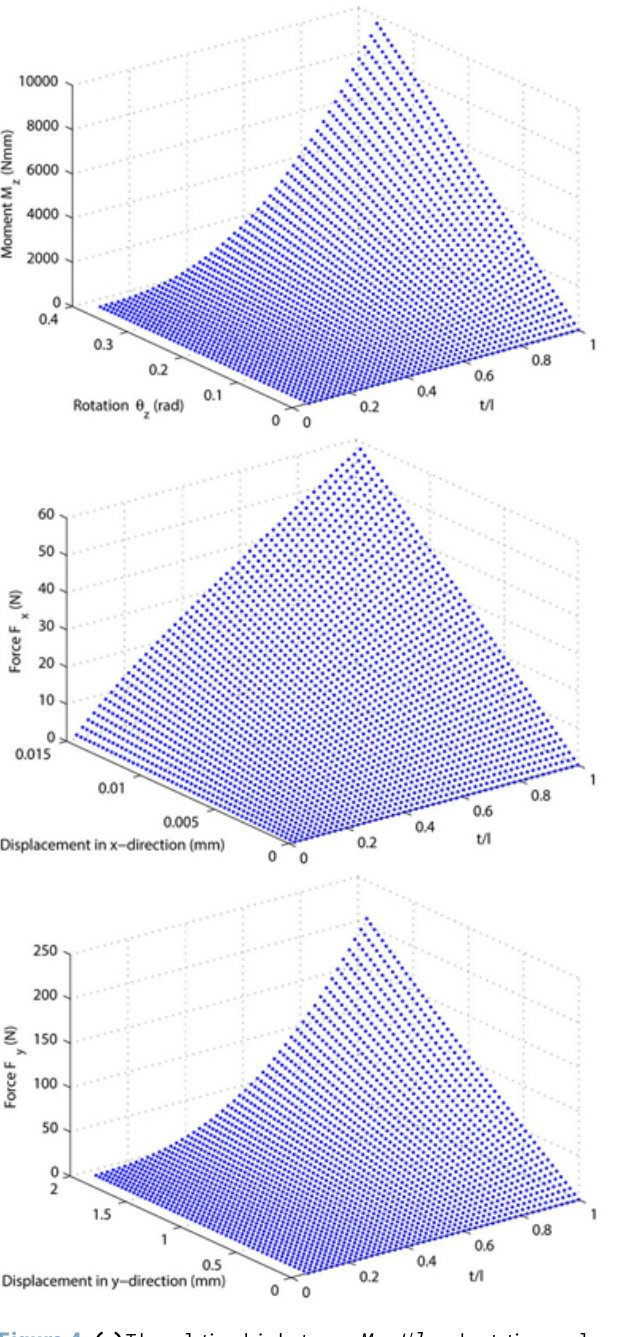
Figure 4. (a) The relationship between M z , t / l , and rotation angle, θ z ; (b) The relationship between F x , t / l , and displacement in x di- rection; (c) The relationship between F y , t / l , and displacement in y direction.